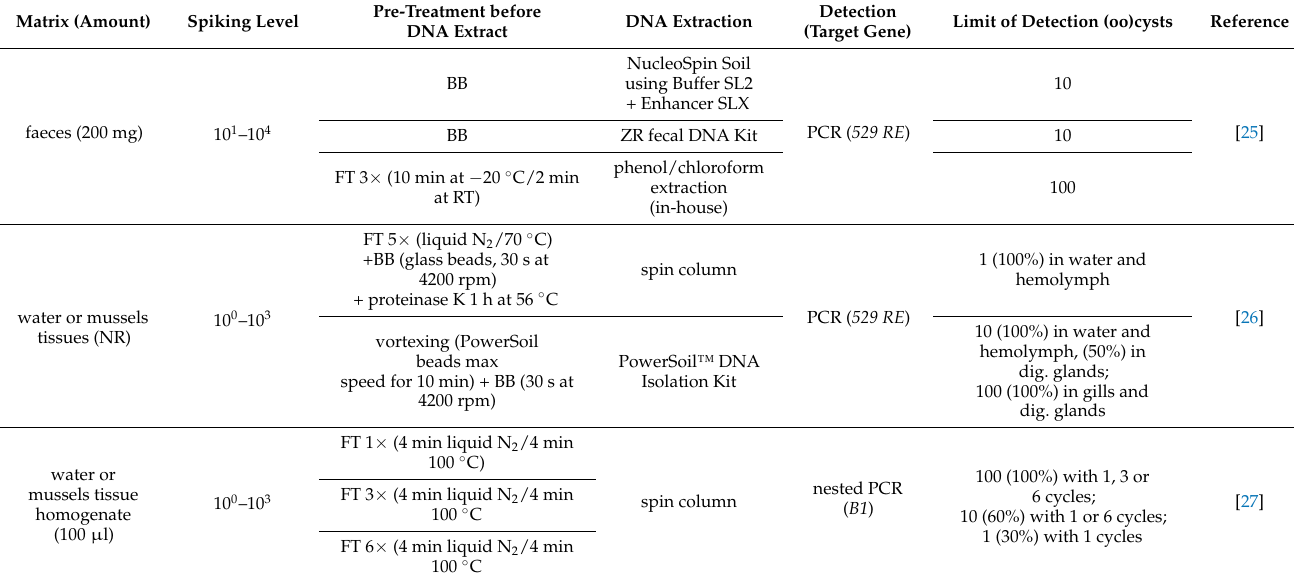
Table 3. Studies comparing the performance of freeze and thaw cycles vs bead-beating as pre-treatment procedure to DNA extraction from Toxoplasma gondii